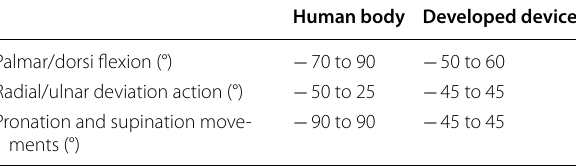
Table 1 Maximum range of motion of the device and the human wrist joint